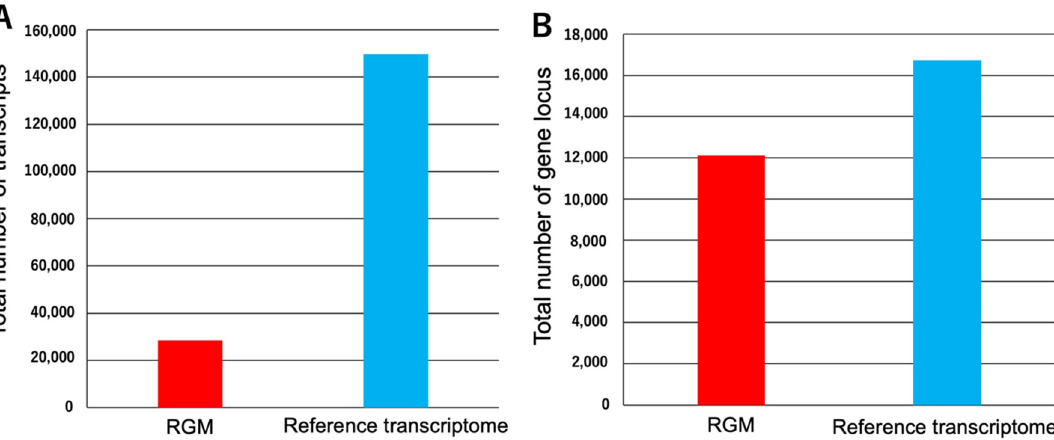
Figure 2. Comparisons of the total numbers of transcripts and gene loci in the reference gene model (RGM) and the reference transcriptome data. ( A ) Comparisons of the total number of transcripts and both datasets. ( B ) Comparisons of the total numbers of gene loci in both datasets via the gffcompare program. Table 1. Number of annotated amino acid sequences.